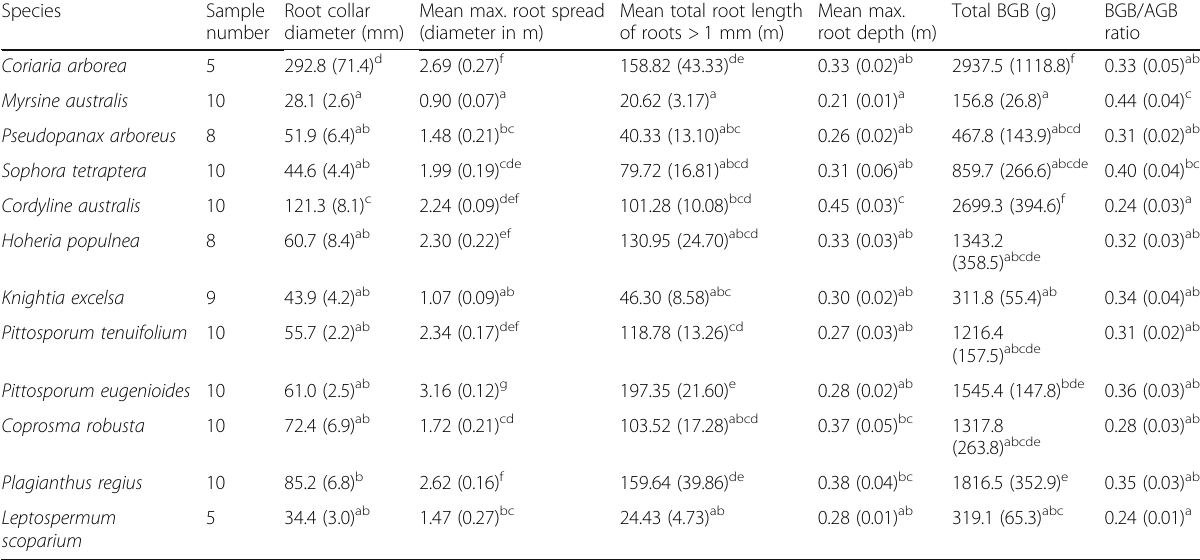
Table 1 Trees sampled and mean root growth metrics at year 5